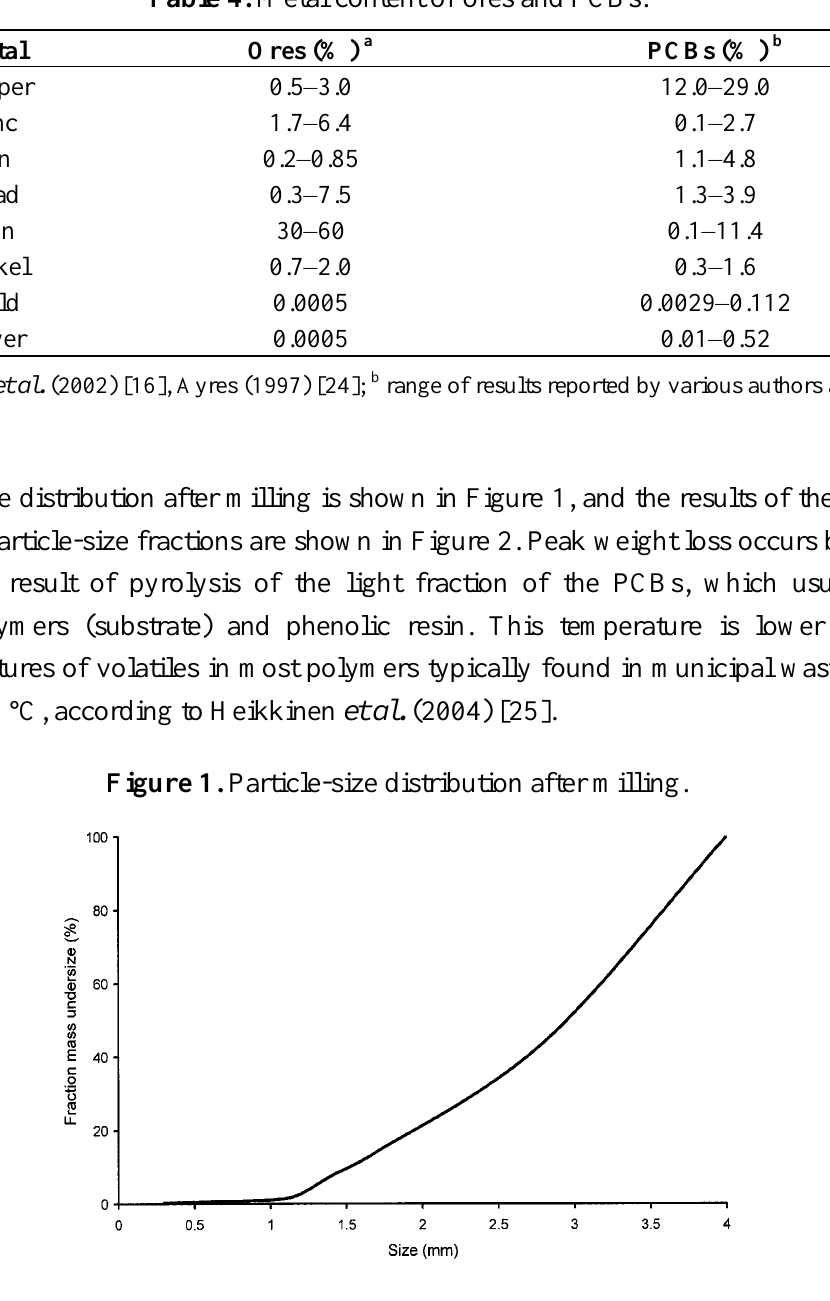
Table 4. Metal content of ores and PCBs.